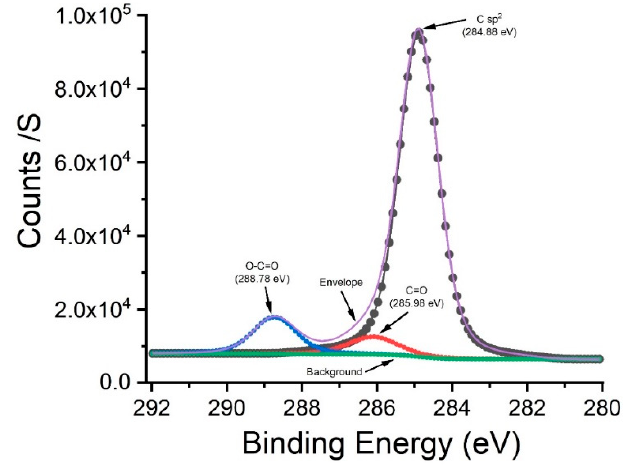
Figure A1. High-resolution XPS scan of C sp 2 in the carbon film.